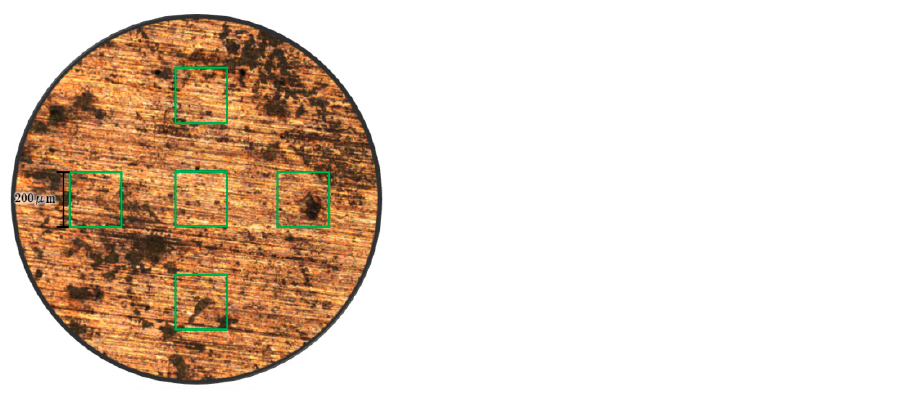
Figure 7. The top view of a sample’s surface showing the areas selected for surface analysis. The surface topographies of the original sample’s surface, and one of the forged sample’s surface, under different amplitudes of 0.5, 1, 1.5, 2, 3.5, and 6 µ m chosen from these three groups are shown in Figure 8a–g, respectively.